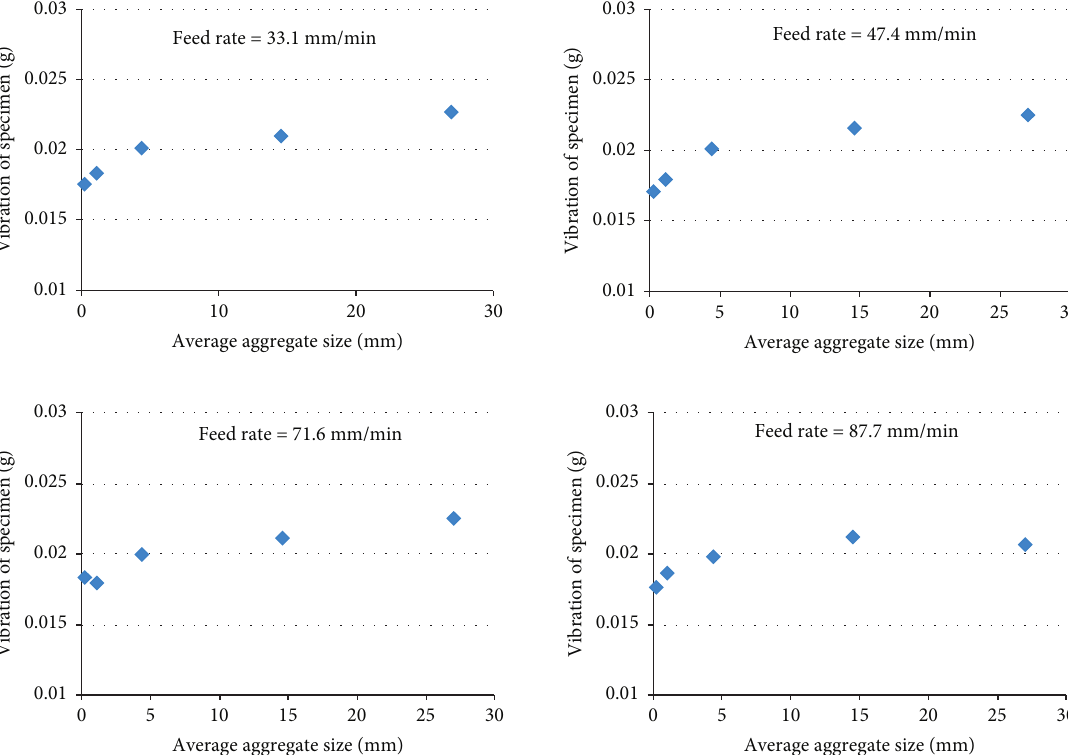
Figure 5: Specimen vibration vs. average aggregate